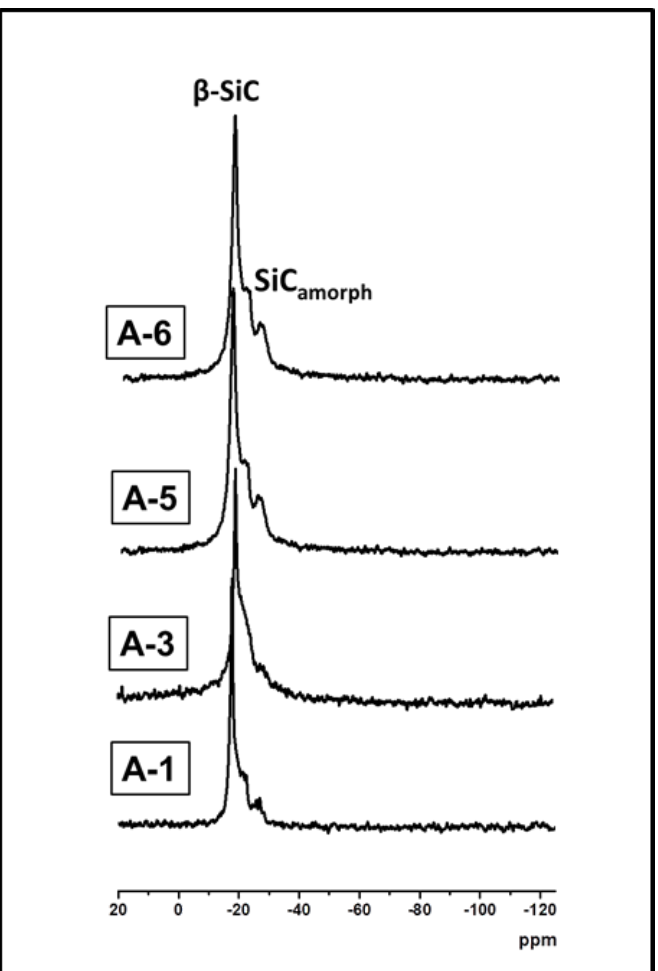
Figure 6. 29 Si MAS NMR spectra of SiC and SiC/C microspheres obtained at different DVB/PHMS w / w ratio: A-1 = 0.17, A-3 = 0.48, A-5 = 0.80, A-6 = 0.97. Raman spectroscopy study provides information on the structure of the C f